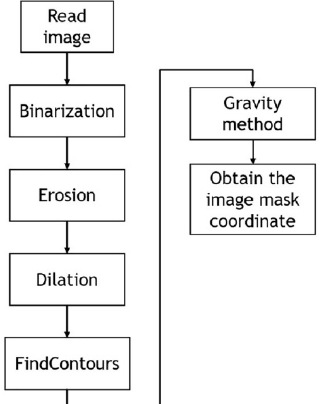
Figure 5. Image identification procedure [4].